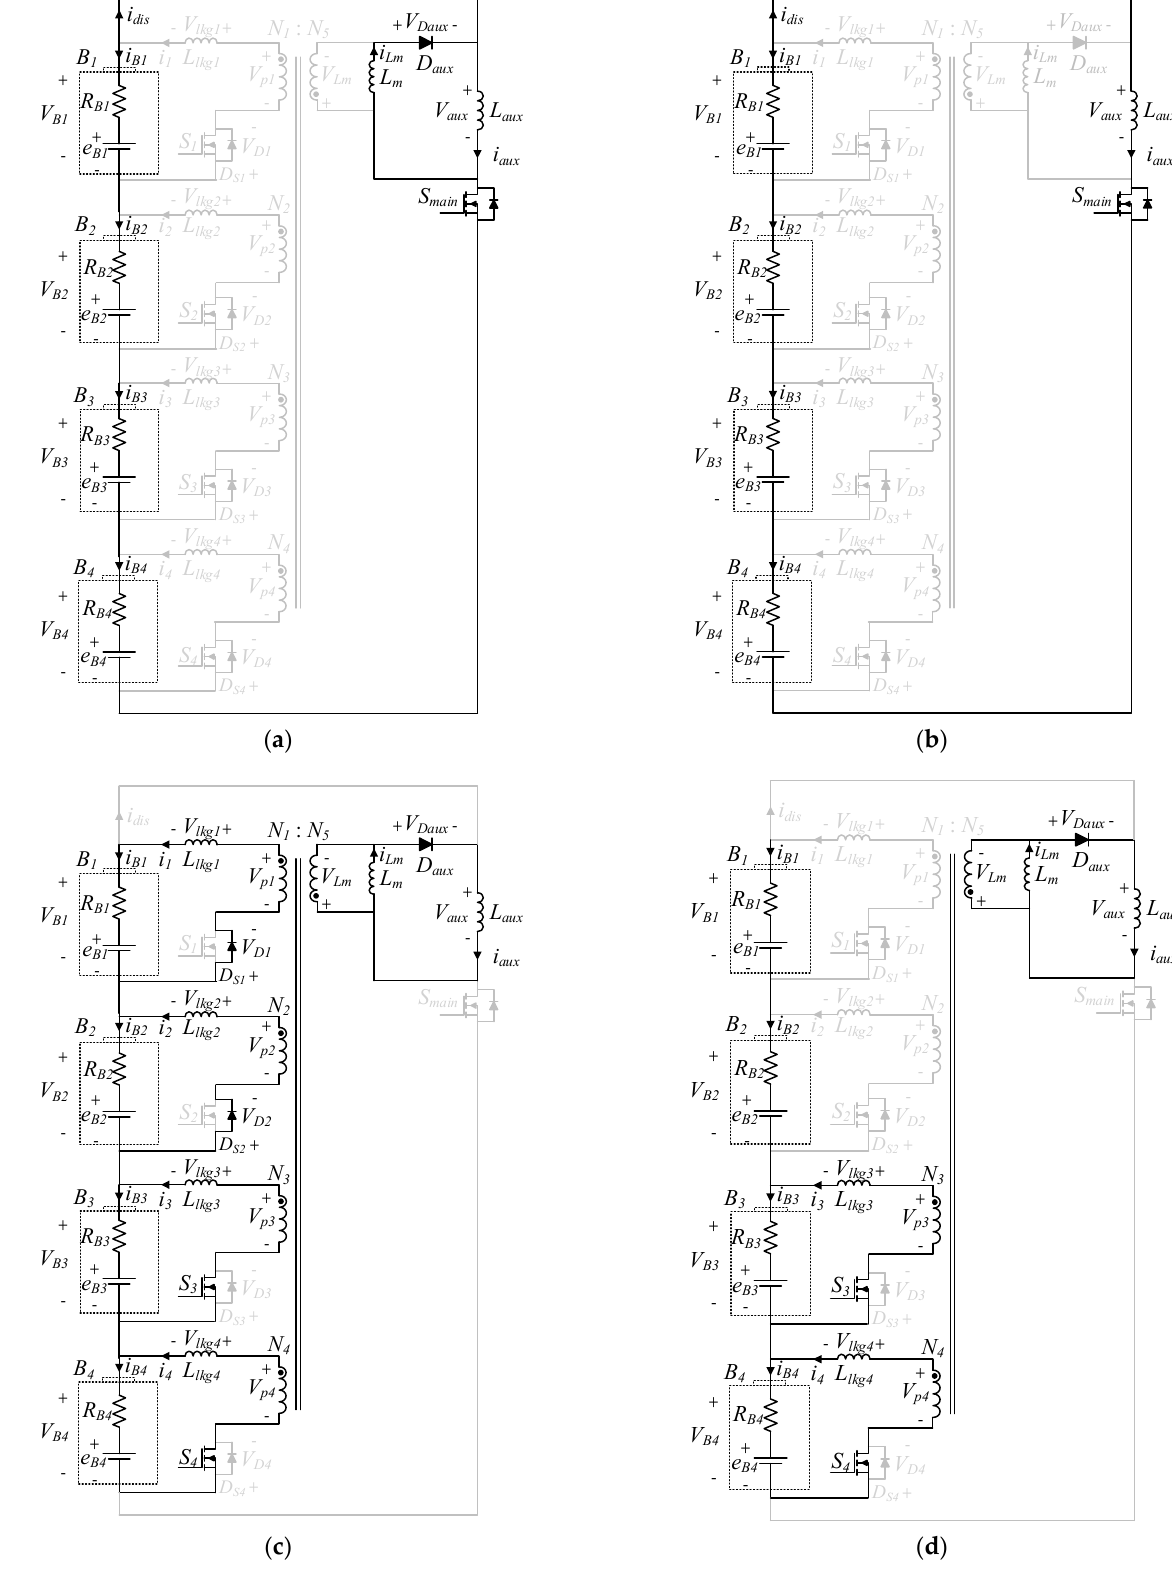
Figure 7. Operation modes of the proposed circuit: ( a ) mode 1, ( b ) mode 2, ( c ) mode 3, and ( d ) mode 4 . (2) Mode 2 ( t 1 ~ t 2 ): Mode 2 begins at t 1 with i Lm , and converges to zero. In this mode, D aux is reverse-biased, and i dis is equal to i aux . The i dis is expressed as (7), and the slope is determined by L aux . The i aux increases linearly in the same way as in Mode 1, as shown in (8); it has a maximum value of I max at t 2 , as shown in (9) and Figure 8a.